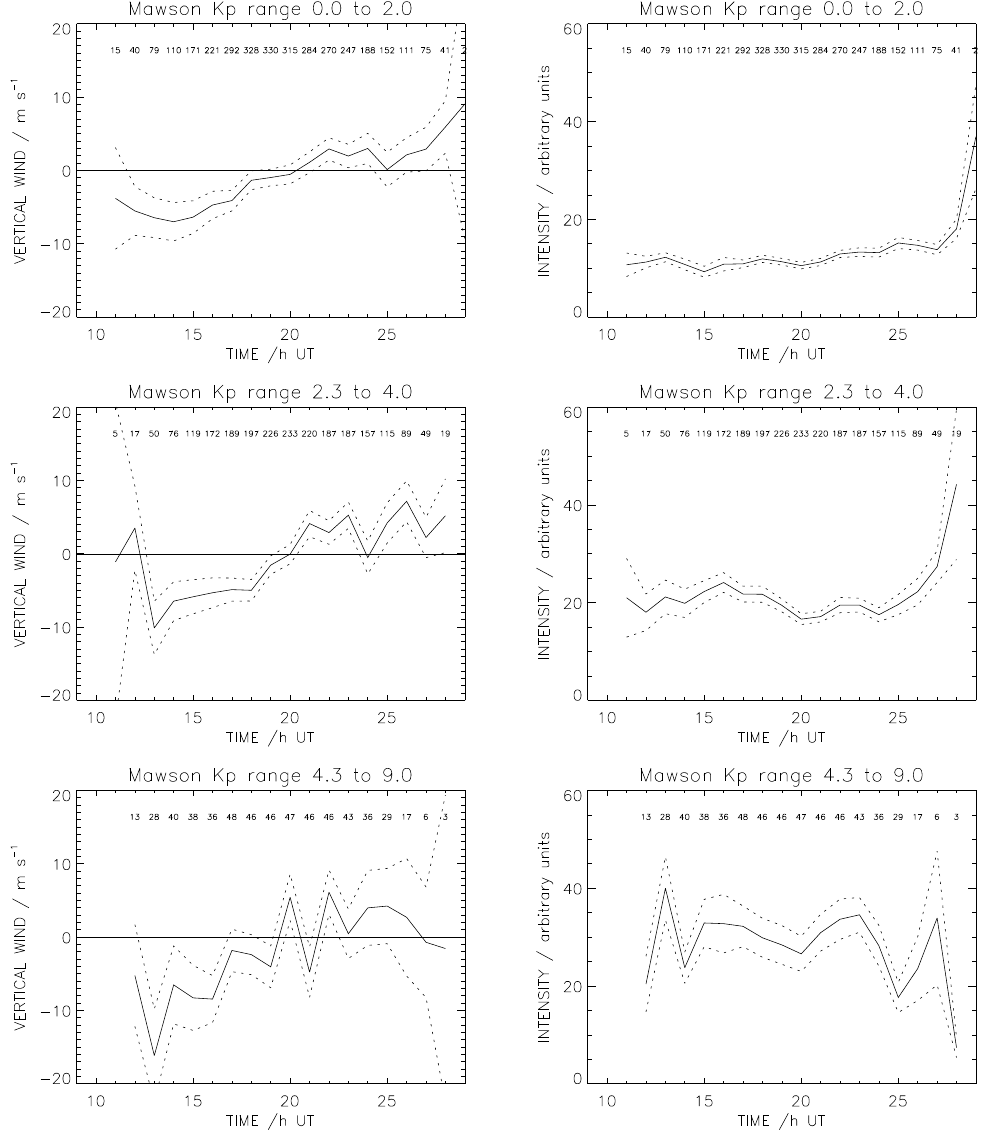
Fig. 6. Mawson hourly mean vertical winds (left) and intensity (right) in three K p ranges, 0.0 to 2.0, 2.3 to 4.0, and 4.3 to 9.0. The number of points in hourly means are indicated at the top of the plots. Standard errors are indicated by dashed